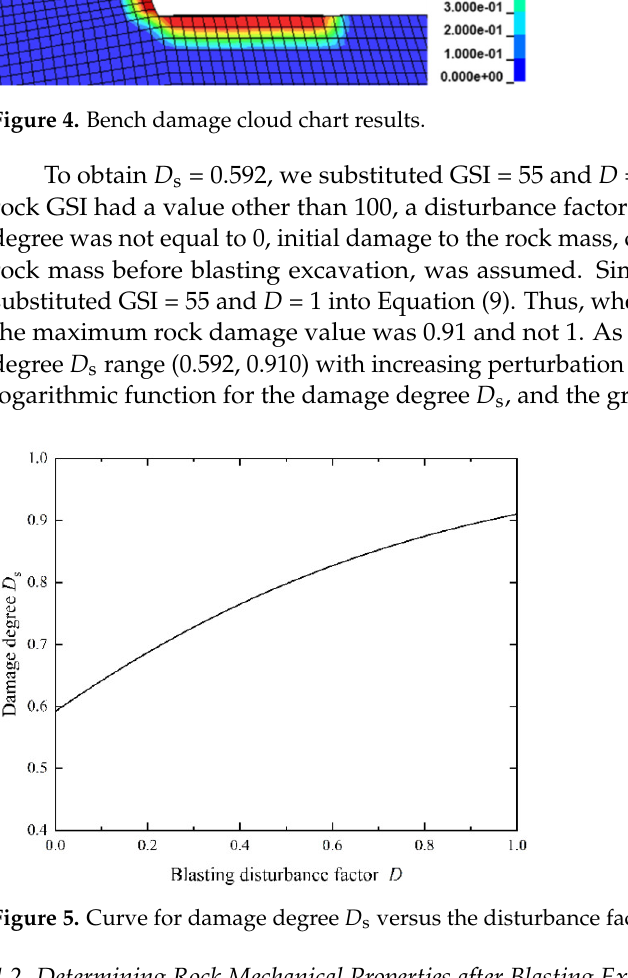
Figure 4. Bench damage cloud chart results.